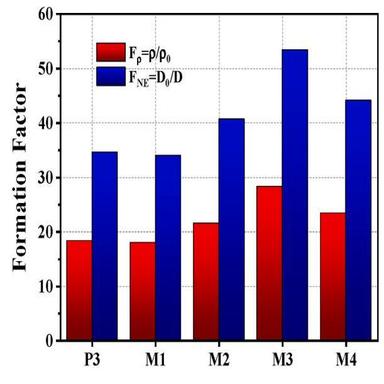
Formation factor calculated by two methods.